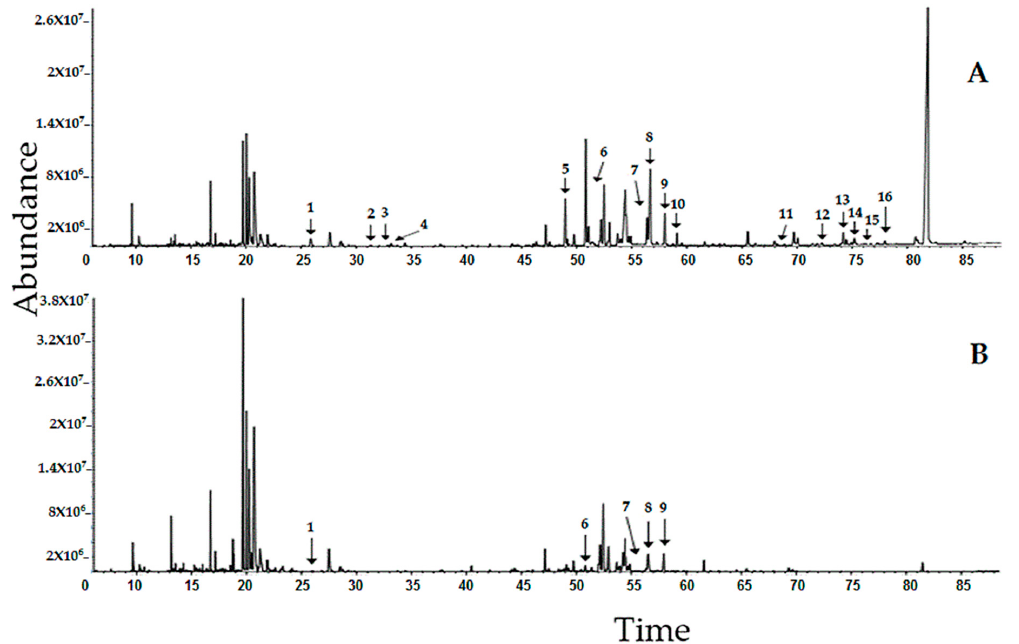
Figure 3. Representative chromatogram of the methanol extract ( A ) and water extract ( B ) of T. scandens leaves. Peak assignments: 1 —palmitic acid, 2 —phytol, 3 —linoleic acid, 4 — α -linolenic acid, 5 —1-monopalmitin, 6 —